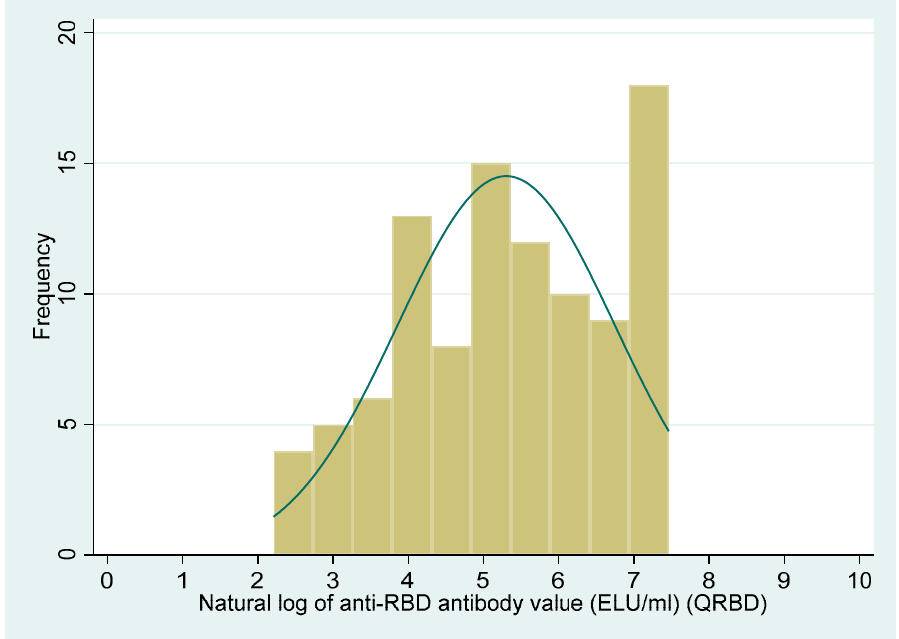
Figure 2. Distribution of anti-RBD antibodies (ELU/mL) among study participants (the scale is a natural logarithm for anti-RBD antibodies).